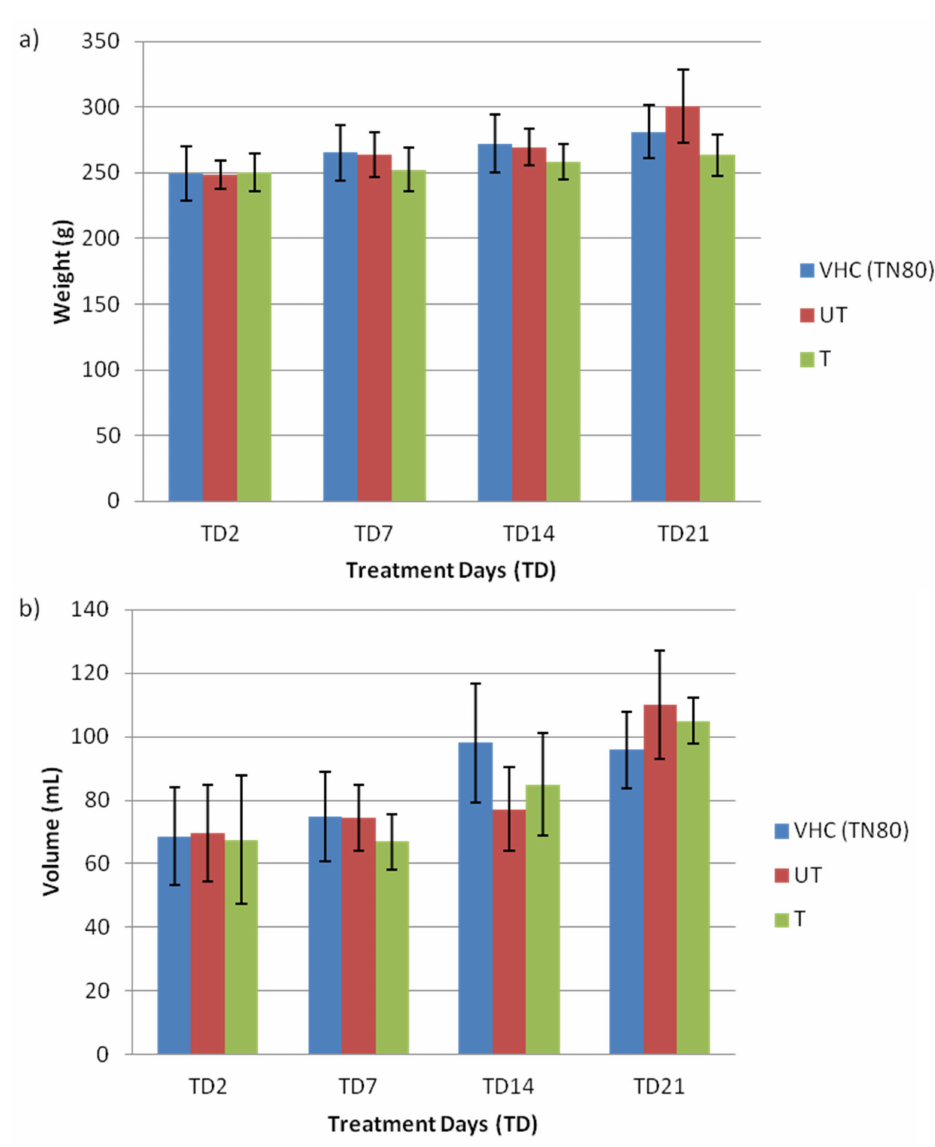
Figure 1. Effects of BPA on ( a ) body weight and ( b ) drinking patterns of pregnant rats ( n = 3–5 rats per